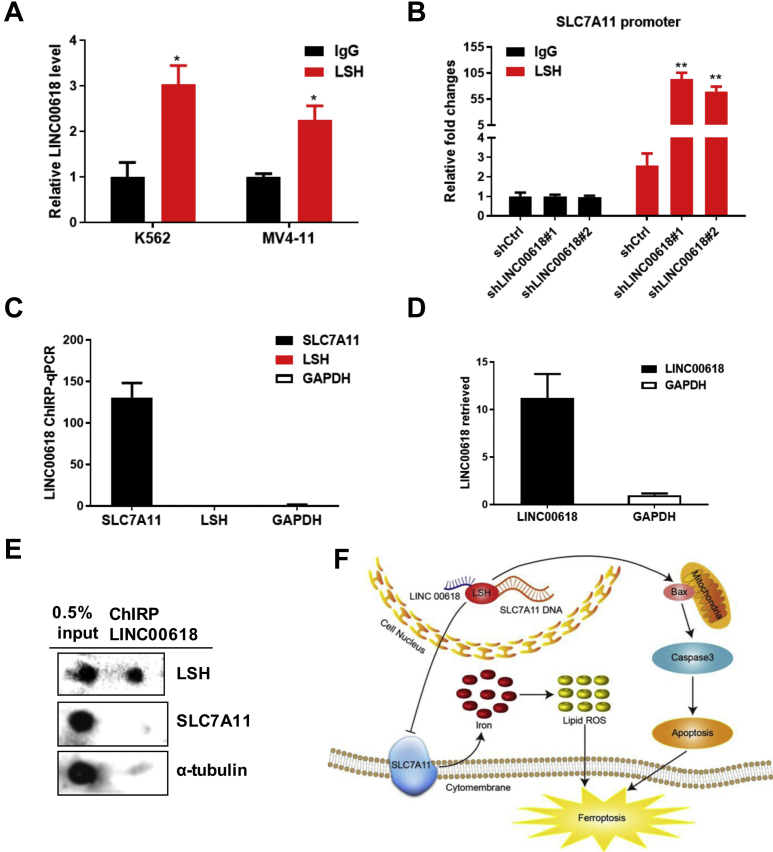
LINC00618 Recruits LSH to the Promoter Regions of SLC7A11(A) RIP assays indicated that LINC00618 can be sequestered by LSH in K562 and MV4-11 cells. (B) ChIP-qPCR assays indicate that LSH is recruited to the promoter regions of SLC7A11 in HL60 cells after the knockdown of LINC00618 with SLC7A11 ChIP primer #1. (C) ChIRP enriches for LINC00618. GAPDH served as negative controls. (D) LINC00618 ChIRP-qPCR detects LSH and SLC7A11. (E) Dot blot analyses of LINC00618 ChIRP retrieves LSH and SLC7A11. (F) Working model for LINC00618 in cell apoptosis and ferroptosis. Nuclear LINC00618 amplification reduces LSH expression. Decreased LSH inhibits SLC7A11 transcription and expression through occupying the promoter, leading to cell ferroptosis. Moreover, LINC00618 overexpression increases the expression levels of BAX and cleaved caspase-3 and in turn, triggers apoptosis. Lastly, LINC00618 accelerates ferroptosis independent of apoptosis. Data are shown as the mean ± SEM; n ≥ 3 independent experiments, two-tailed Student’s t test: ns, nonsignificant (p > 0.05), ∗p < 0.05, ∗∗p < 0.01, ∗∗∗p < 0.001.